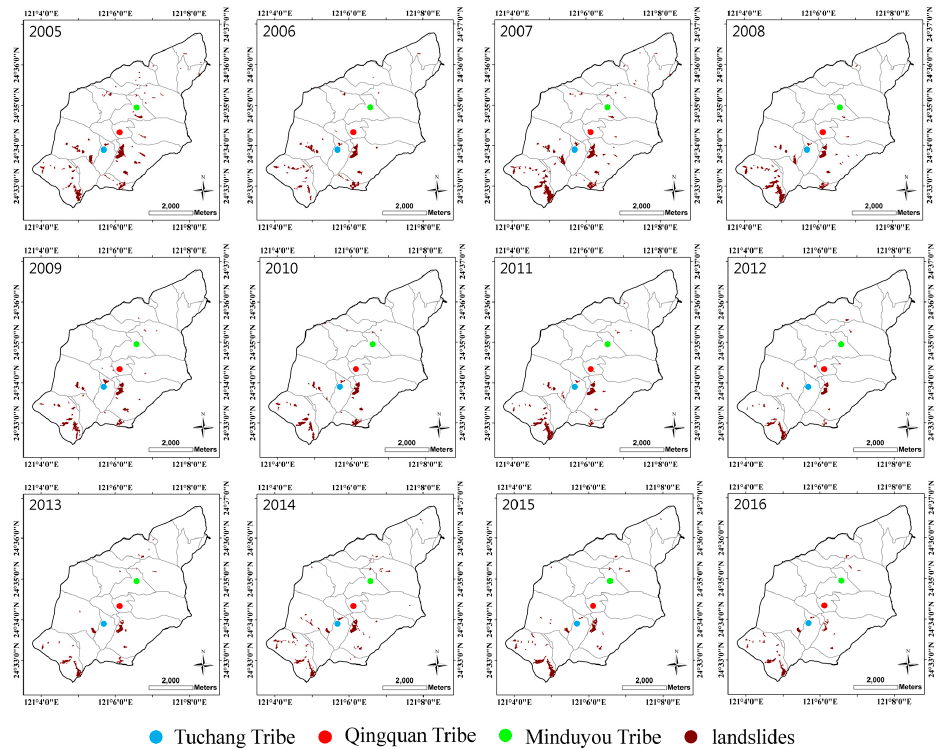
Figure 8. The annual landslide inventory overlaid on the 22 optimum sub-watersheds to